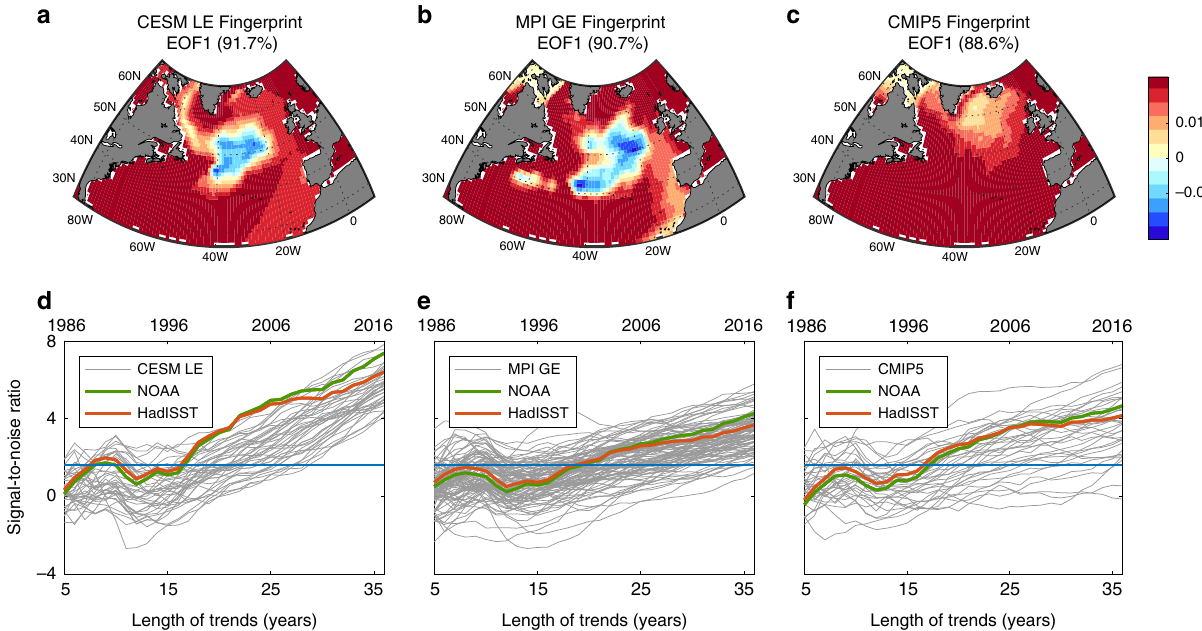
Fig. 2 Fingerprints and signal-to-noise analysis. The leading mode ( fi ngerprint) of the 1982 – 2017 North Atlantic sea surface temperature anomalies in the a Community Earth System Model Large Ensemble (CESM-LE), b Max Planck Institute for Meteorology Grand Ensemble (MPI-GE), and c Coupled Model Intercomparison Project Phase 5 (CMIP5). The percentage in each panel represents the variability explained by each mode. Signal-to-noise ratio for North Atlantic sea surface temperature as a function of the length of trends (and corresponding last year of trend) since 1982 using the fi ngerprint and noise from d CESM-LE, e MPI-GE, and f CMIP5. The signal in the green and orange lines is calculated using the satellite-based observations in NOAA, and HadISST, respectively. The signal in the gray lines in each panel is calculated using each realization in the CESM-LE, MPI-GE, and CMIP5 datasets. The blue horizontal line marks the 5% signi fi cance